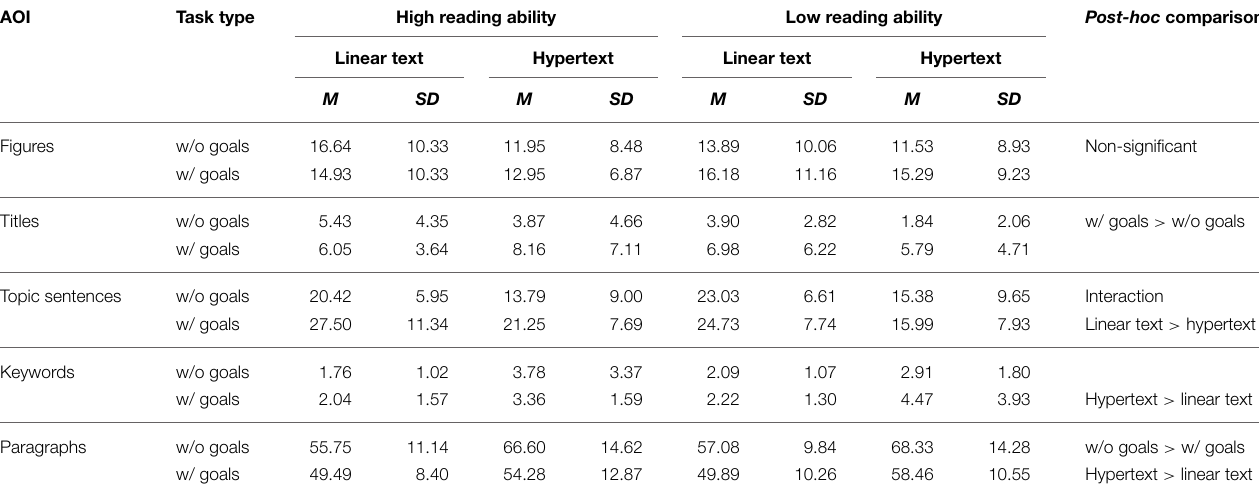
TABLE 3 | Mean and SD values of the PTVT for each AOI (unit: %). AOI Task